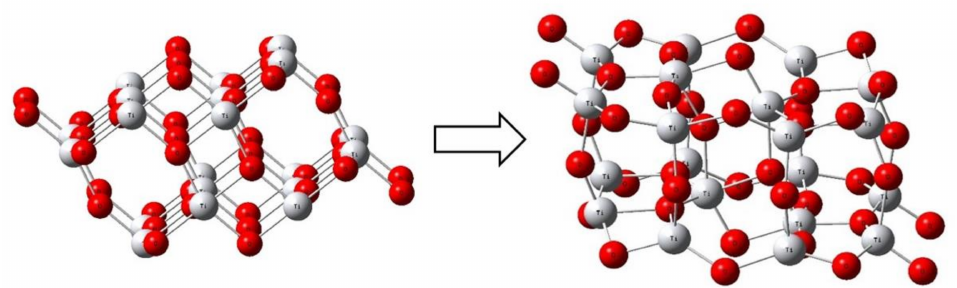
Figure 5. Geometry of the initial and relaxed anatase Ti 20 O 40 cluster (symmetry C 2h